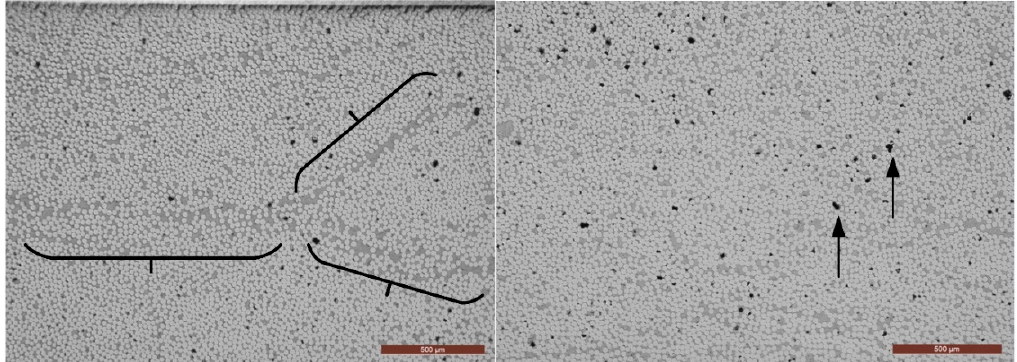
Figure 10. Microsections of open bath ( left ) und conical ii_chamber ( right ) composites .